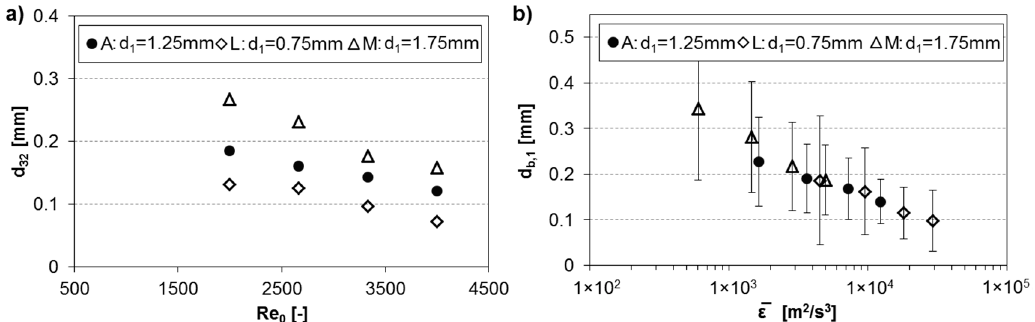
Figure 14. Impact of downstream channel hydraulic diameter d 1 on micronozzle induced turbulent bubble breakup. Geometrical nozzle parameter besides d 1 are held constant for investigated inlay elements: d − 1 = 1 mm, α − 1 = 8 ◦ , d 0 = 0.5 mm, l 0 = 2.5 mm, α 1 = 47.5 ◦ . Hydraulic diameter d 1 exhibited following values, i.e., nozzle inlay L: d 1 = 0.75 mm, nozzle inlay A: d 1 = 1.25 mm, nozzle inlay M: d 1 = 1.75 mm. Volumetric flow rates of V tot = 60, 80, 100, and 120 mL/min are employed for each nozzle inlay. ( a ) Obtained Sauter diameter of broken up bubbles plotted over Reynolds number in smallest cross section for different d 1 ; ( b ) mean bubble diameter of refined dispersed phase plotted over mean energy dissipation rate for various d 1 .